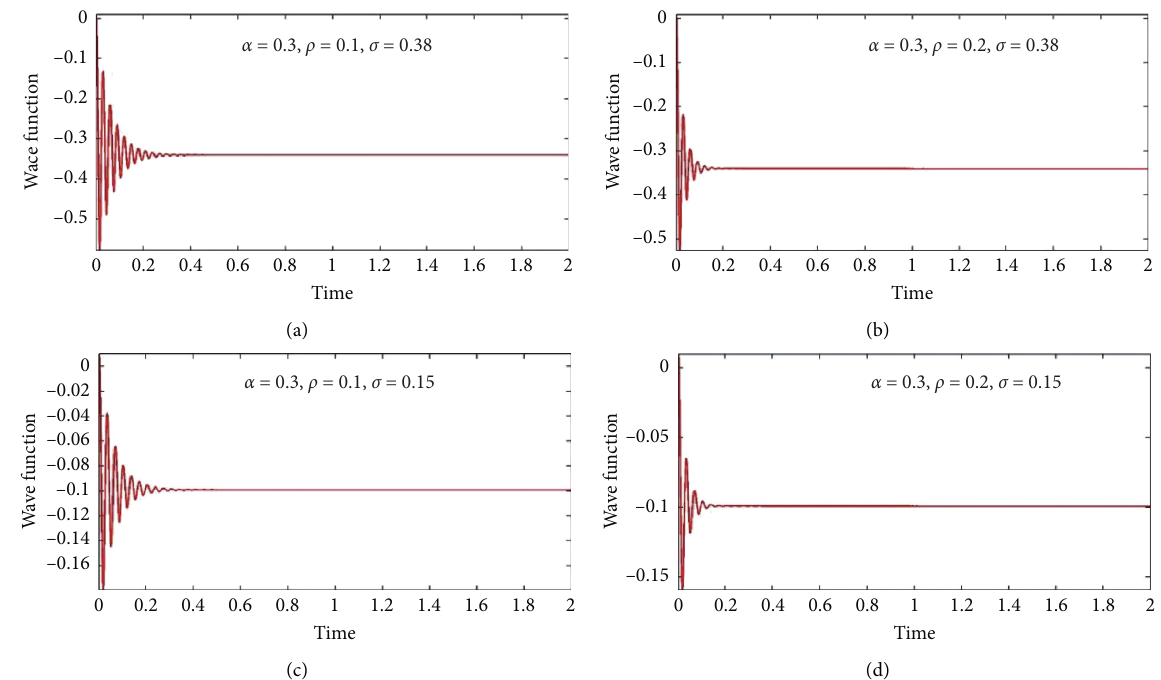
Figure 3: Wavefunctiongeneratedfromthepartialdifferentialequationatlowkineticenergy.(a) α � 0 . 3 , ρ � 0 . 1 , σ � 0 . 38;(b) α � 0 . 3 , ρ � 0 . 2 , σ � 0 . 38;